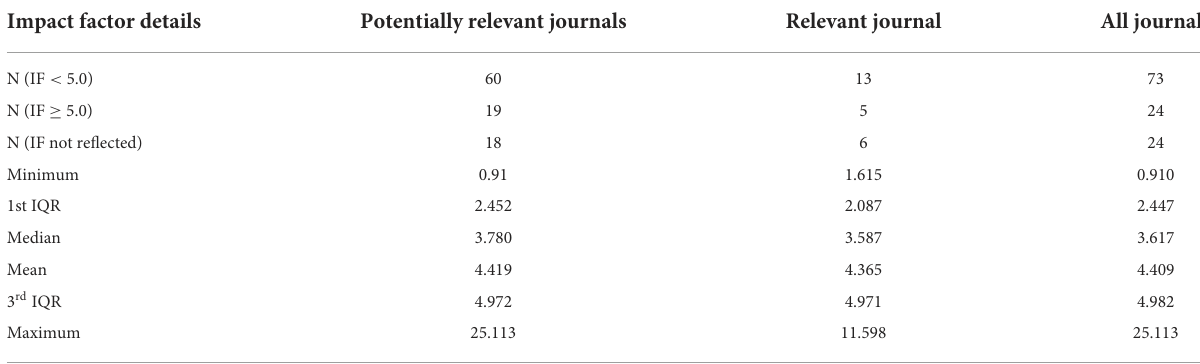
TABLE 2 The trends in impact factor relative to journals marked as potentially relevant or relevant to researchers based at the ICMM. Impact factor